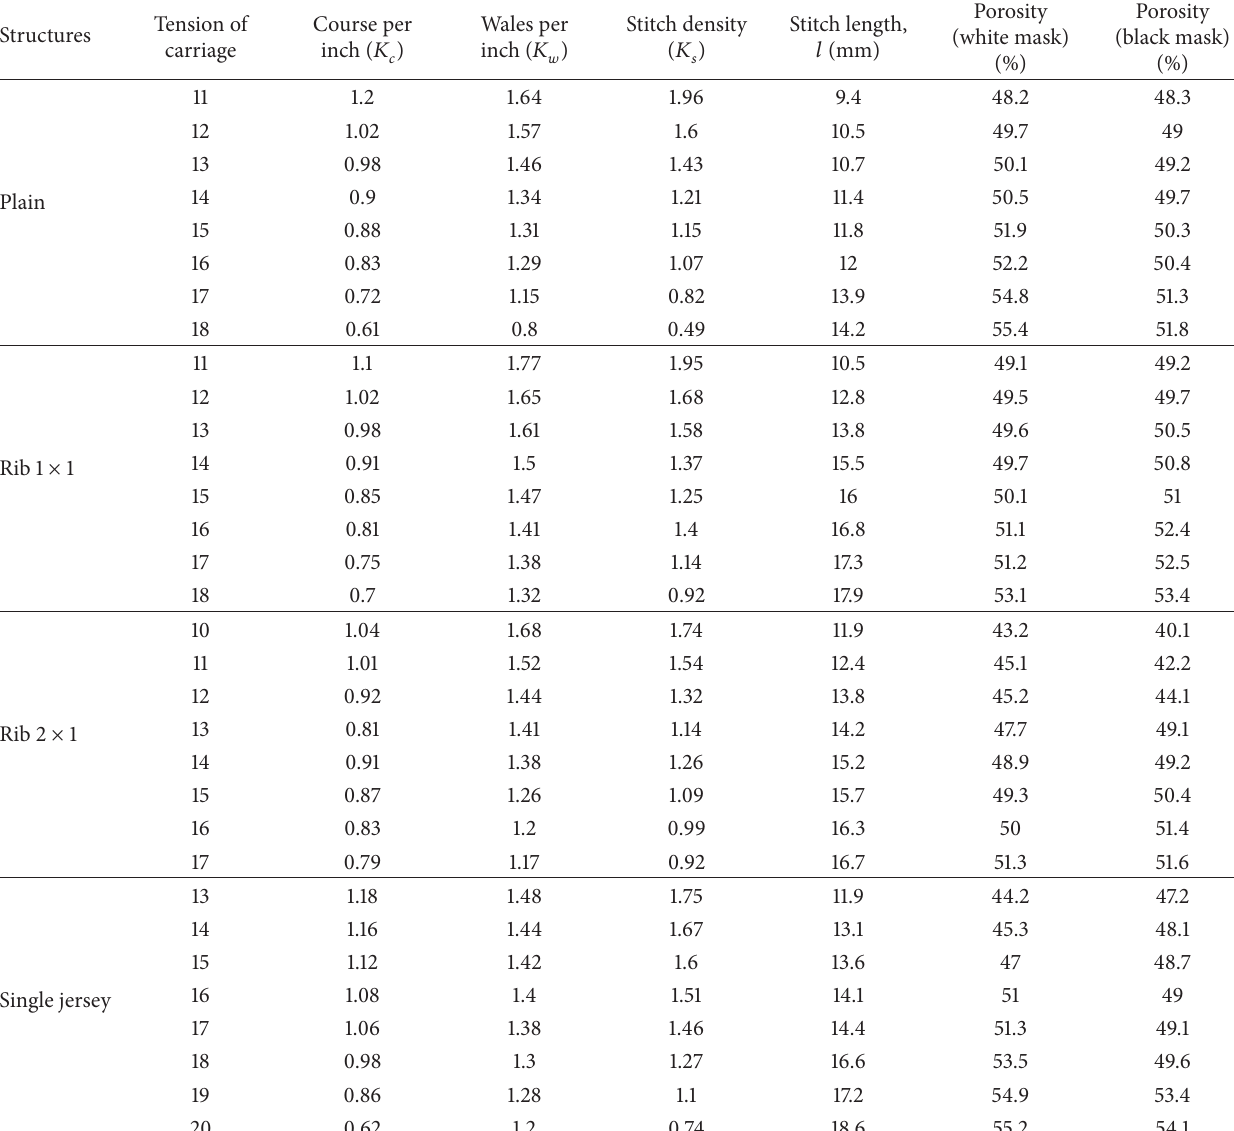
Table 2: Results of fabric structural parameters of FKM knitted samples and image analysis results of percentage of void values of black and white region of images of fabric.